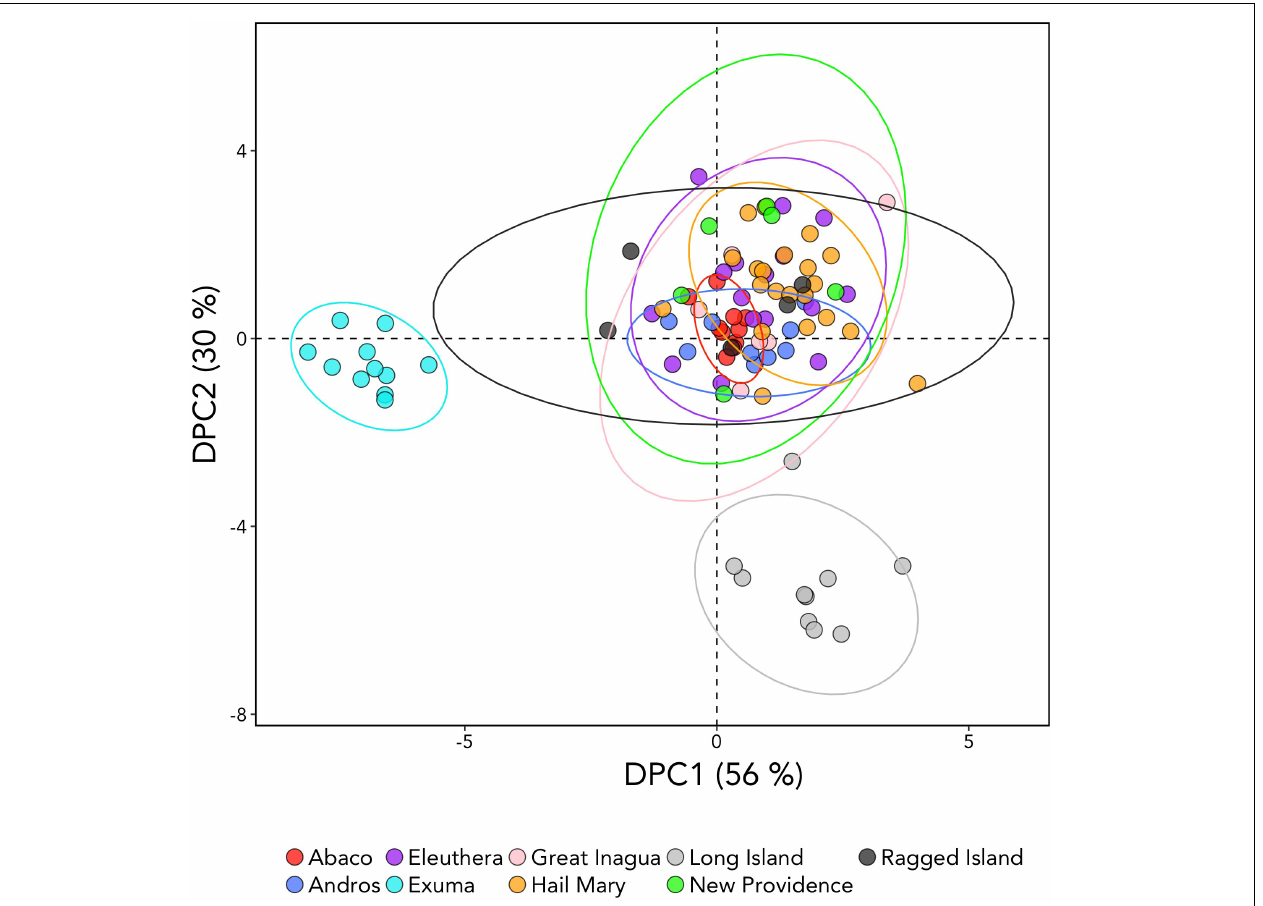
FIGURE 3 | Discriminate analysis of principal components (DAPC) analysis of Nassau grouper based on 10,031 SNP loci illustrating separations of Exuma and Long Island from other sampled locations within The Bahamas. The DAPC was constructed using 40 principal components (PCs) and 3 discriminate functions. The percent variation explained by each axis appears in